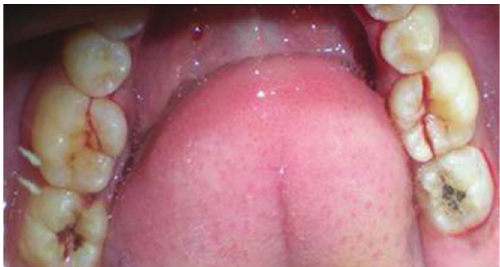
Figure 4: Occlusal view of vertical fracture mesiodistally with 36 and oblique fracture of the mesiolingual cusp with 46.